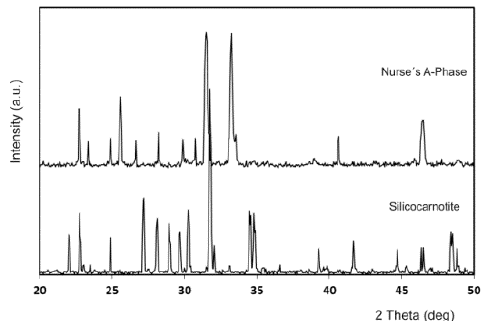
Figure 1. X-ray diffraction patterns of the synthesized materials: Nurse’s A-phase and silicocarnotite.